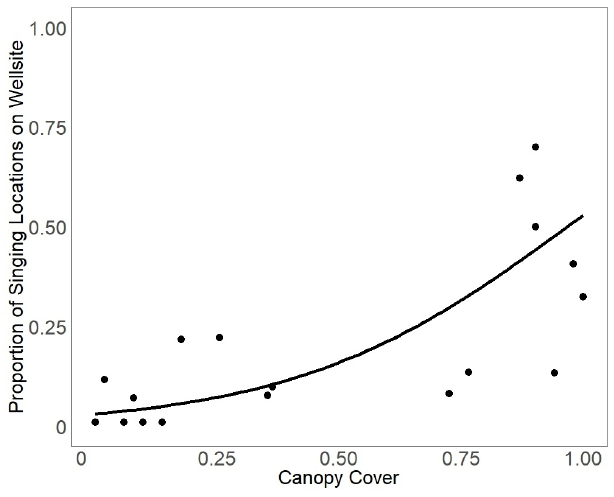
Fig. 2 . Plot of the predicted proportion of total Ovenbird ( Seiurus aurocapilla ) singing events on the wellsite as a function of canopy cover on the wellsite, with the number of conspecifics held constant at two